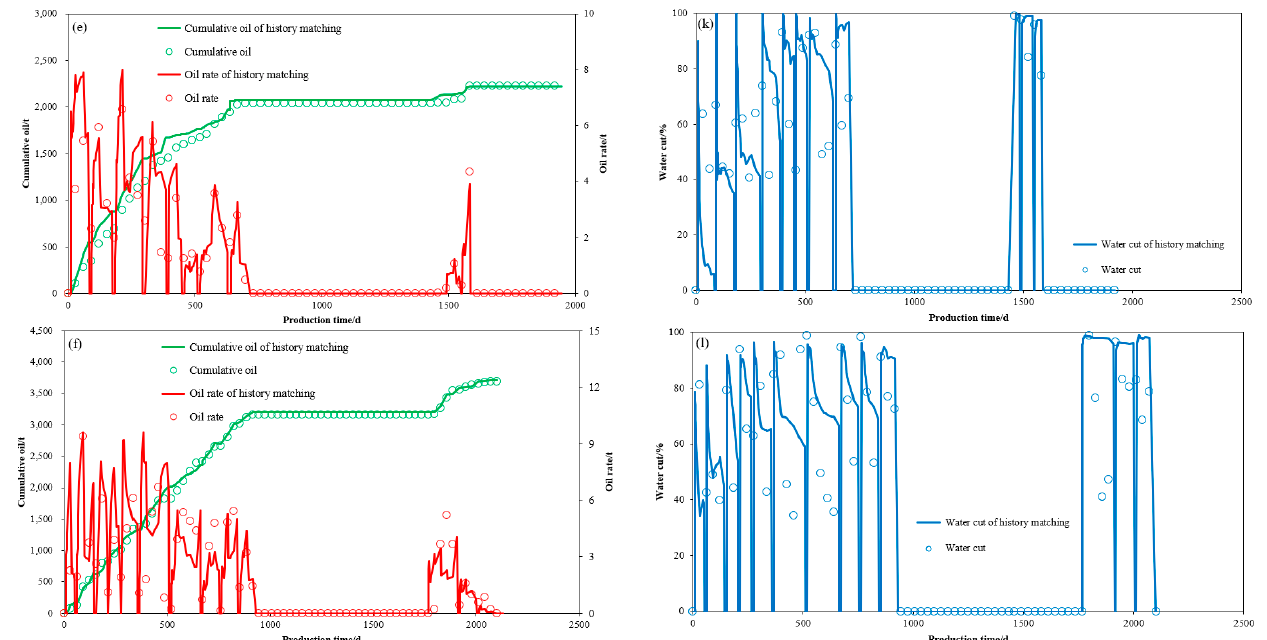
Figure 8. History matching of cumulative oil, oil rate, and water cut for three types of production wells. ( a – f ) History matching of cumulative oil and oil rates for P226, P235, P188, P185, X296 and X265, respectively. ( g – l ) History matching of water cut for P226, P235, P188, P185, X296 and X265, respectively. P226 well and P235 well belong to the first type, P188 well and P185 well belong to the second type and X296 and X265 belong to the third type.